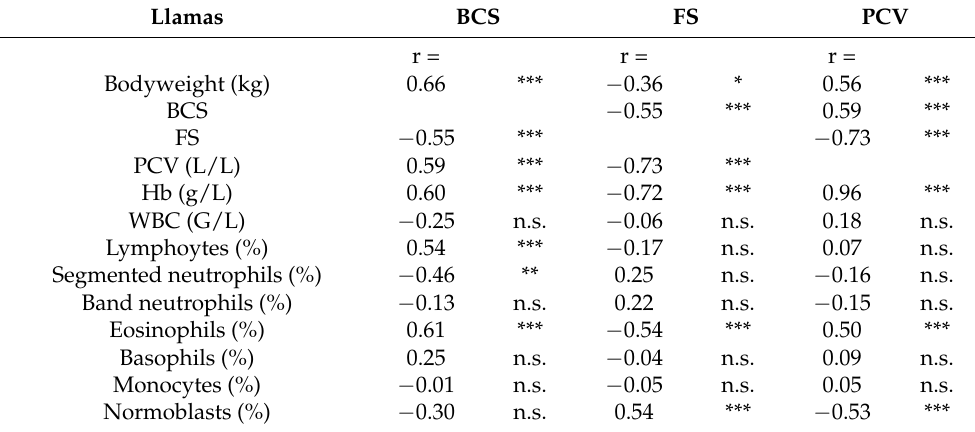
Table 3. Results of Spearman’s correlation for BCS, FS, and PCV with the investigated clinical and haematological parameters in llamas (n = 41). * = p < 0.05; ** = p < 0.01; *** = p < 0.001; n.s. = not